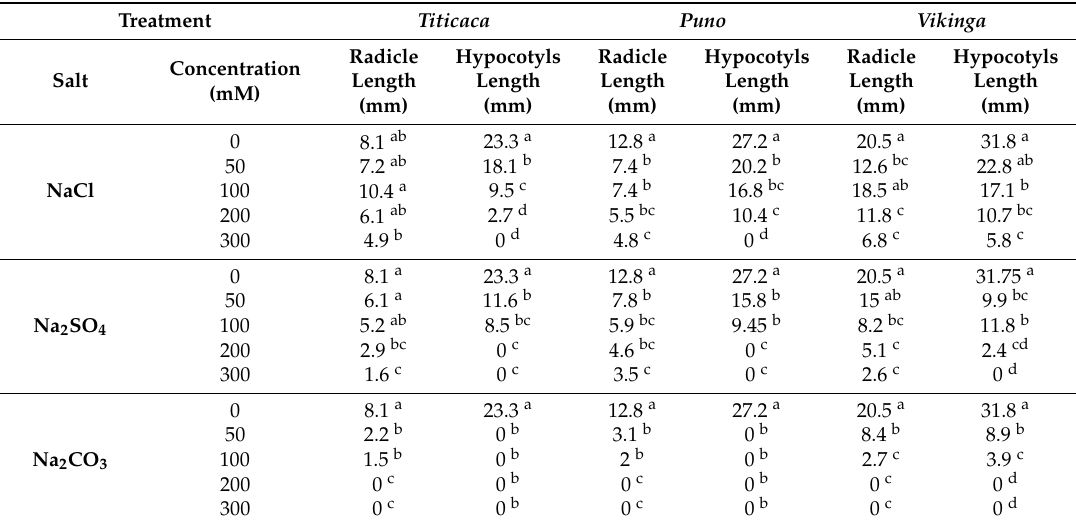
Table 2. E ff ect of NaCl, Na 2 SO 4 and Na 2 CO 3 stresses on the growth of radicle and hypocotyls of Titicaca , Puno and Vikinga cultivars after five days of germination. Di ff erent letters in the same column mean significant di ff erences between treatments, according to Tukey test ( p <